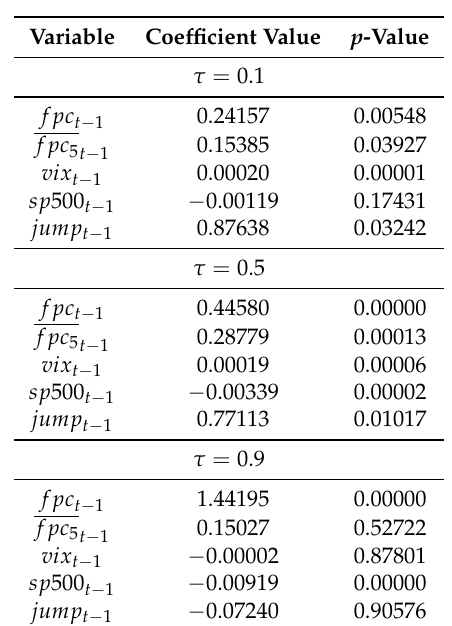
Table 1. Quantile regression results.